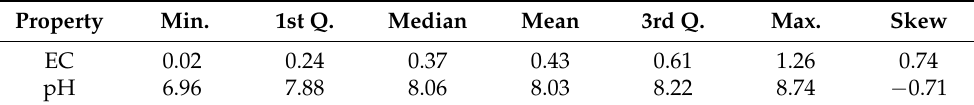
Table 1. Statistics of EC (in mS/cm) and pH.